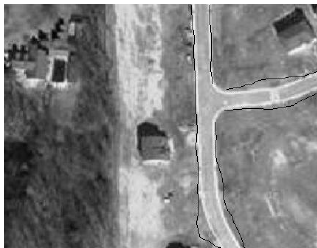
Figure 13: Detected roads using Ziplock Snake According to the literature, the implementation area of Ziplock Snake consists of non-salient roads, indeed. As shown in figure modified by user to generate synthetic shadows.